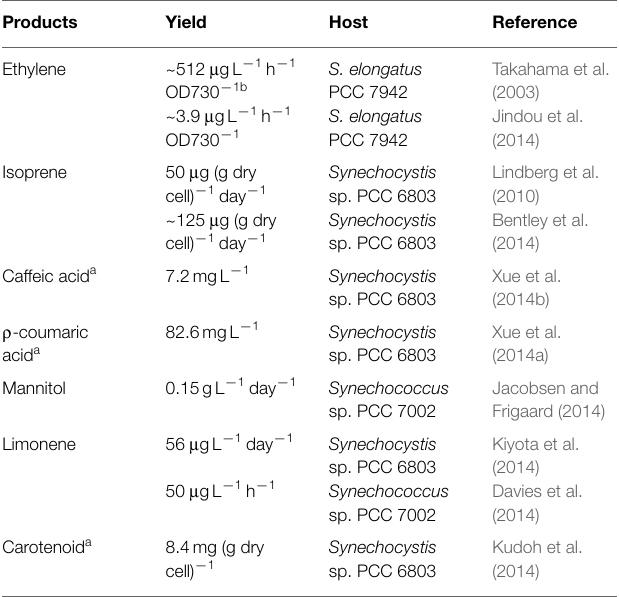
TABLE 1 | Plant secondary metabolites produced by genetically engineered cyanobacteria .